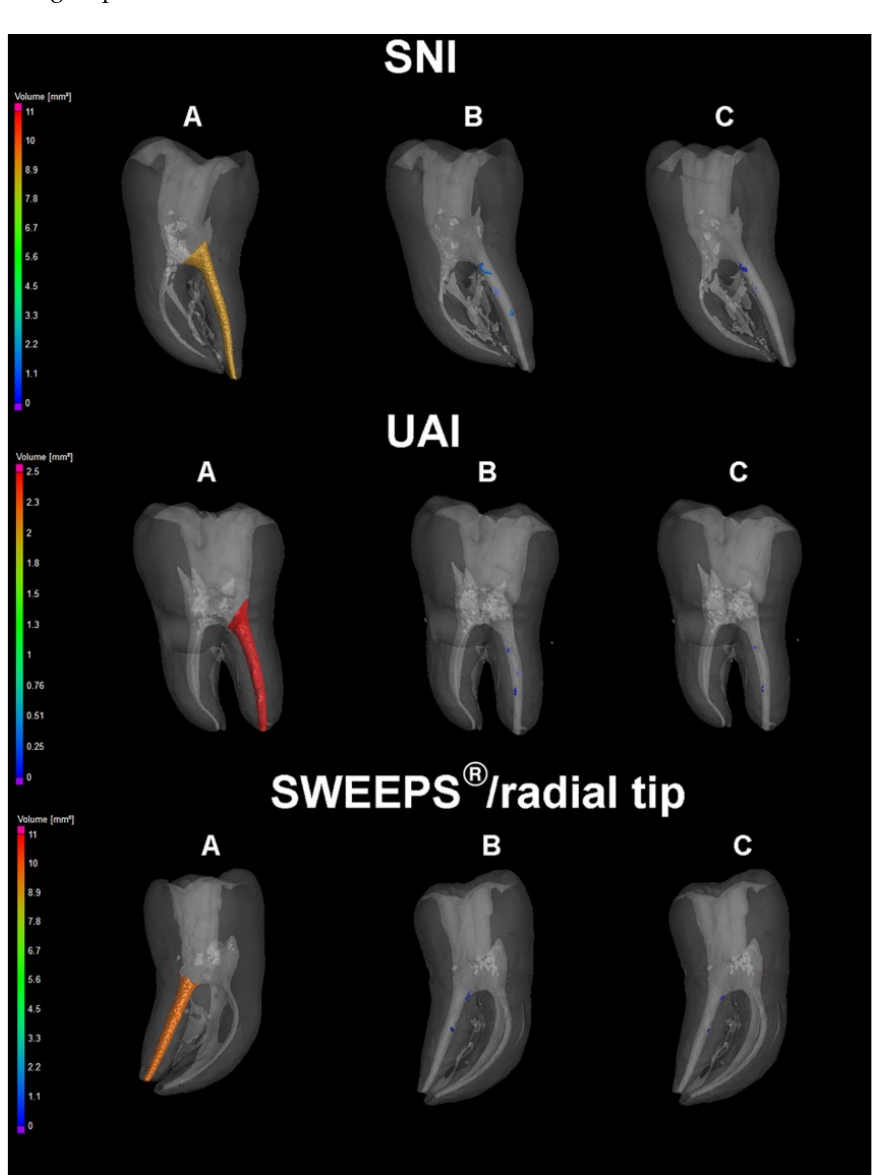
Figure 1. Three-dimensional micro-CT scans of the samples randomly selected from syringe-nee- dle irrigation group (SNI), ultrasonically irrigation group (UAI) and SWEEPS group (SWEEPS) after root canal filling (A), basic retreatment (B) and final irrigation protocol (C).